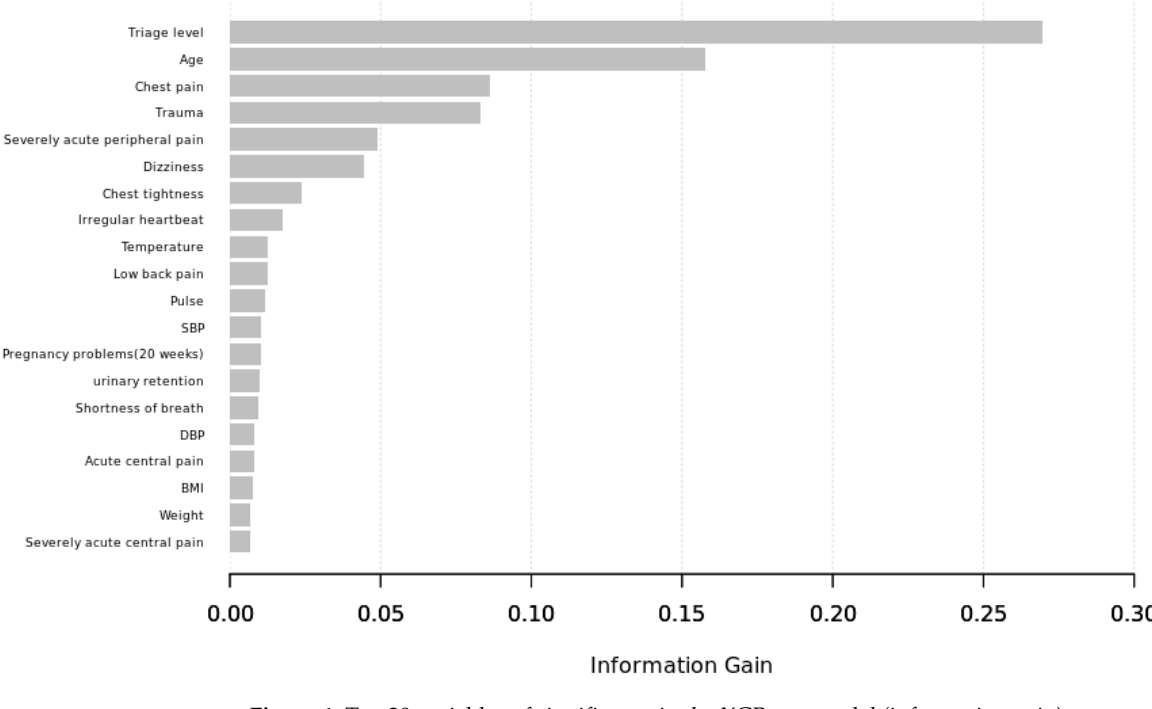
Figure 4. Top 20 variables of significance in the XGBoost model (information gain).